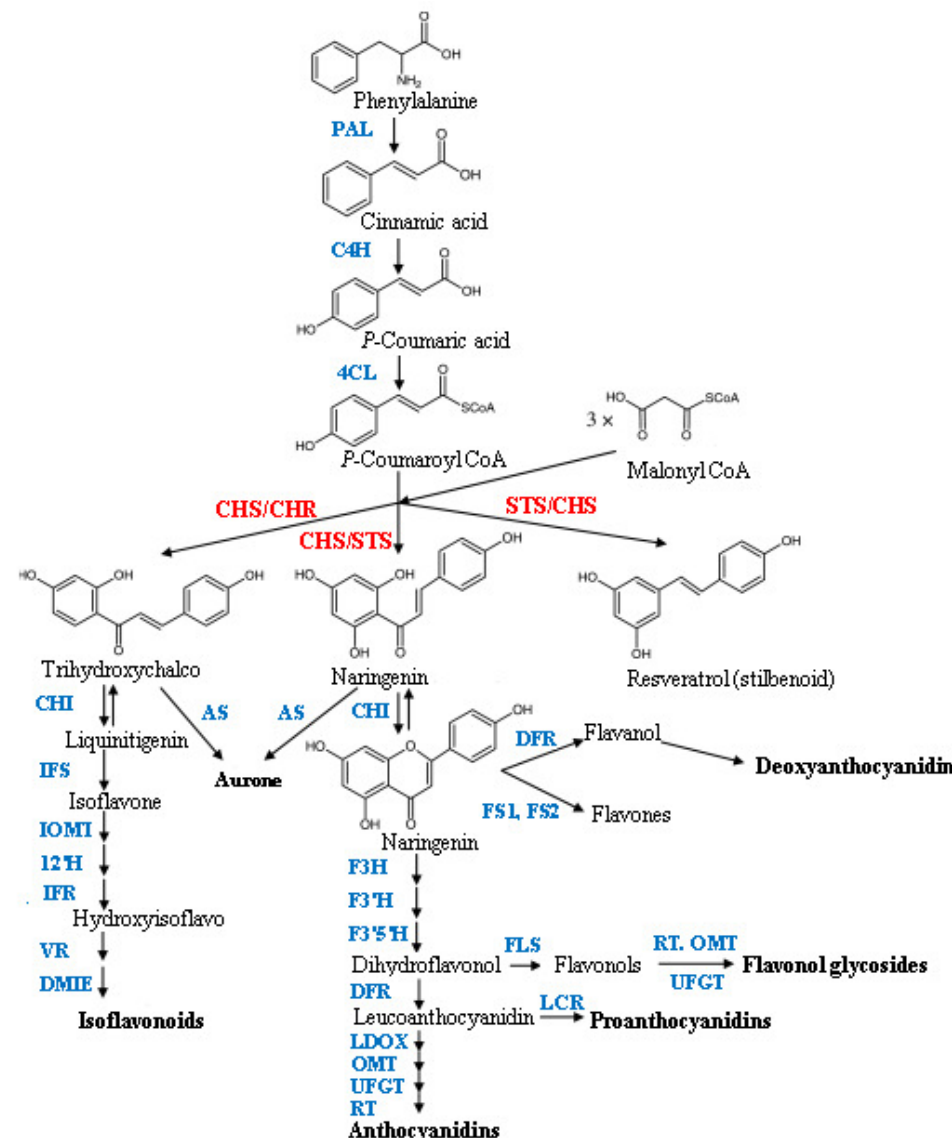
Figure 1. Flavonoid biosynthetic pathway. ANS, anthocyanidin synthase; AS, aureusidin synthase; C4H, cinnamate-4-hydroxylase; CHR, chalcone reductase; DFR, dihydroflavonol 4-reductase; DMID, 7,2'-dihydroxy,4'-methoxyisoflavanol dehydratase; F3H, flavanone 3-hydroxylase; F3'H, flavonoid 3' hydroxylase; F3'5'H, flavonoid 3'5' hydroxylase; FS1/FS2, flavone synthase; I2'H, isoflavone 2'-hydroxylase; IFR, isoflavone reductase; IFS, isoflavone synthase; IOMT, isoflavone O -methyltransferase; LCR, leucoanthocyanidin reductase; LDOX, leucoanthocyanidin dioxygenase OMTO-methyltransferase; PAL, phenylalanine ammonia-lyase; RT, rhamnosyl transferase; UFGT, UDP flavonoid glucosyl transferase; VR, vestitone reductase; STS, stilbene synthase; FLS, flavanol synthase